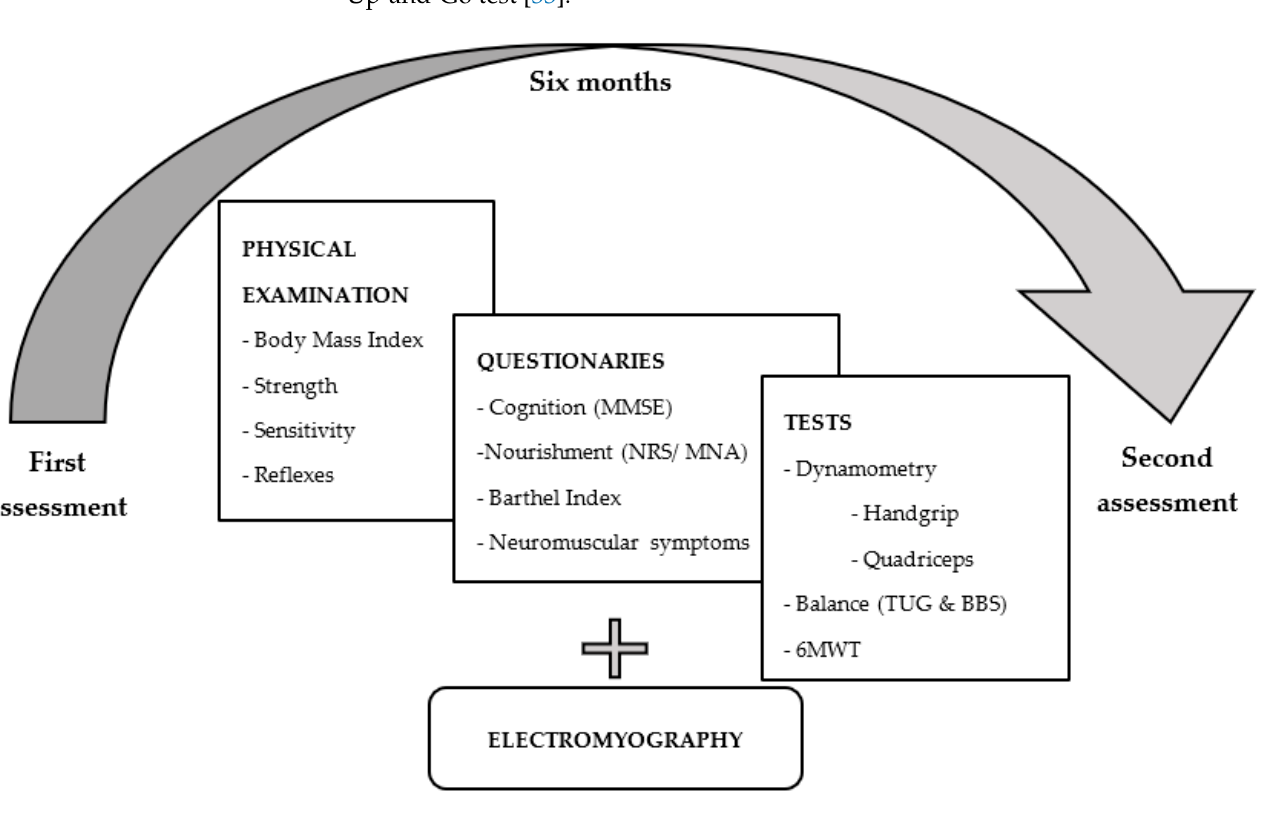
Figure 1. Assessments were performed two times, with six months in between, to 43 patients the first time, and 40 patients the second time. MMSE: Mini-Mental State Examination; NRS: Nutritional Risk Screening; MNA: Mini Nutritional Assessment; TUG: Timed-Up-and-Go Test; BBS: Berg Bal- ance Scale; 6MWT: Six Minute Walk